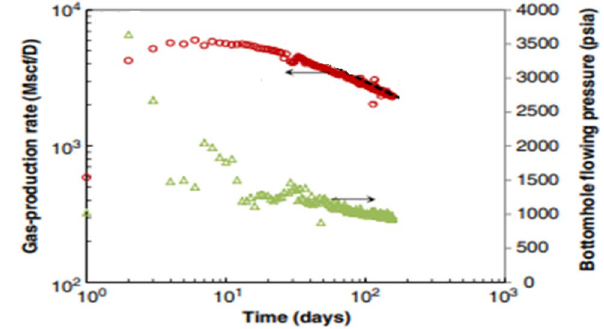
Fig. 29 Bottom hole flowing pressure and flow rate of the field exam- ple (Fuentes-Cruz and Valko